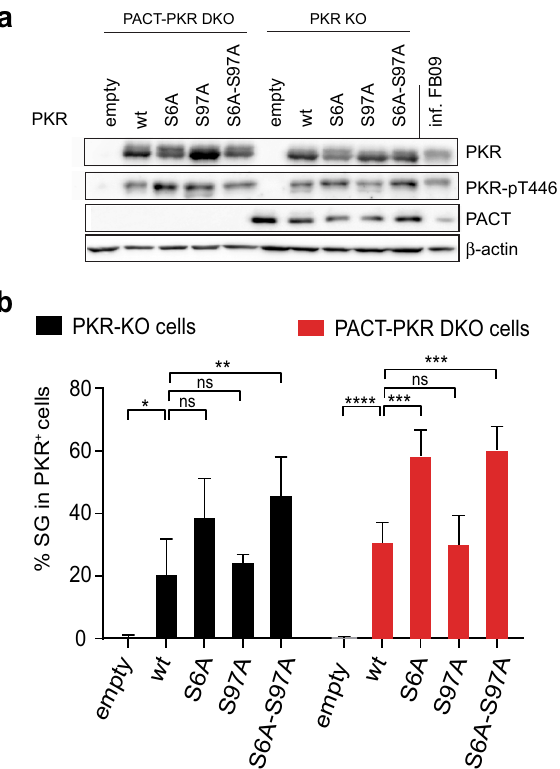
Figure 3. PACT is not required for spontaneous activation of Ser6- and Ser97-Ala PKR mutants. PACT-PKR DKO cells and PKR-KO cells were transfected with plasmids expressing either wt PKR or indicated PKR mutants. After 48 h, PKR activation (phospho-Thr446) was analyzed by western blot ( a ) and stress granule formation was quantified in transfected cells using eIF3 detection by immunofluorescence ( b ). ( a ) Detection of phospho-Thr446 PKR (PKR-pT446), PKR and PACT by western blot. Note the similar activation of PKR in PACT-positive and PACT-deficient cells. β-actin was detected as a loading control. Acquisition was made with a CCD camera (Fusion Solo-S, Vilber) using the Bio1D software (version 15.08). ( b ) Graph (generated with Microsoft Excell 2011) showing the percentage of stress granule-positive cells counted among PKR + cells, for PACT-PKR DKO and PKR-KO cell lines (mean ± SEM) (n = 4). 2-way ANOVA (Graphpad Prism 7) was used to compare mutant and wt PKR in each cell